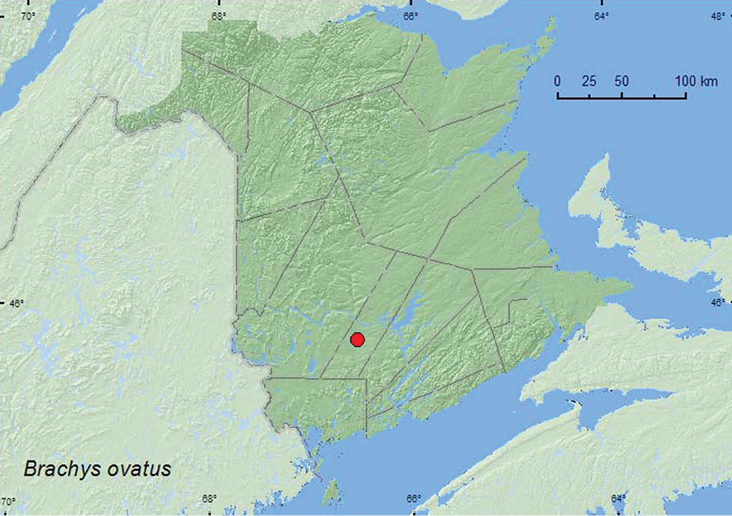
Collection localities in New Brunswick, Canada of Brachys ovatus.